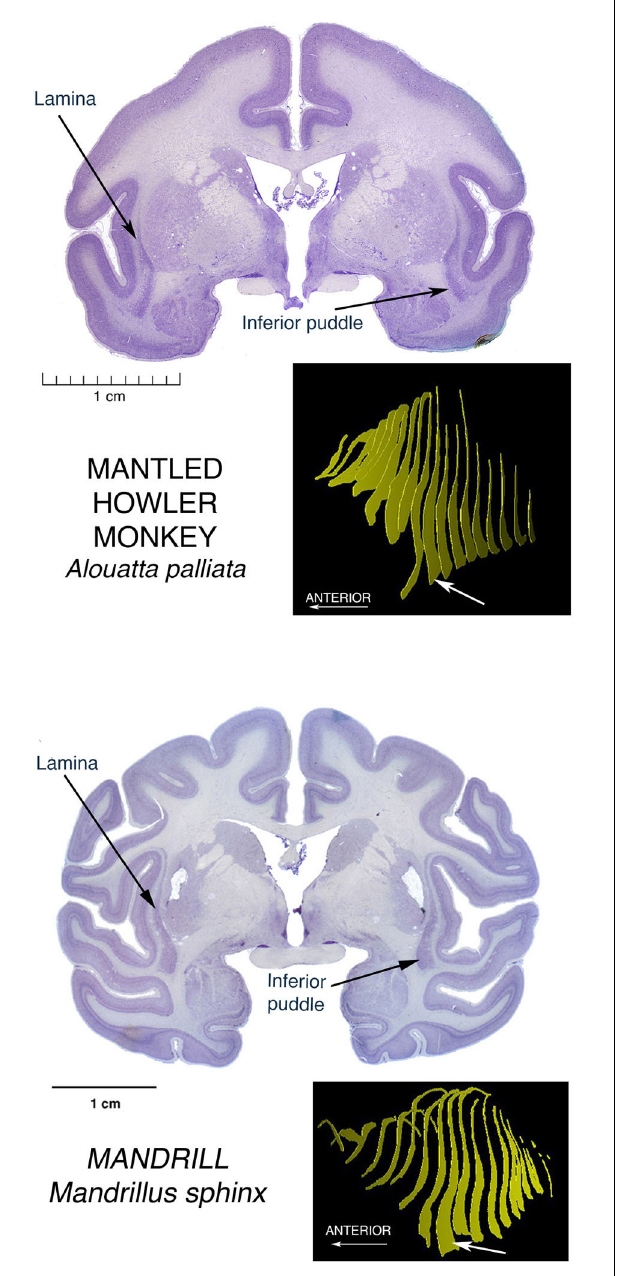
FIGURE 5 | Nissl stained coronal sections through the brains of two anthropoid primates, showing the Inferior Puddle seen in all members of this group that have been investigated, including humans. The New World Platyrrhine monkeys are represented here by the largest of these species, the Mantled Howler Monkey. The other major monkey radiation, the Old World Catarrhine monkeys, is represented here by the brain of a